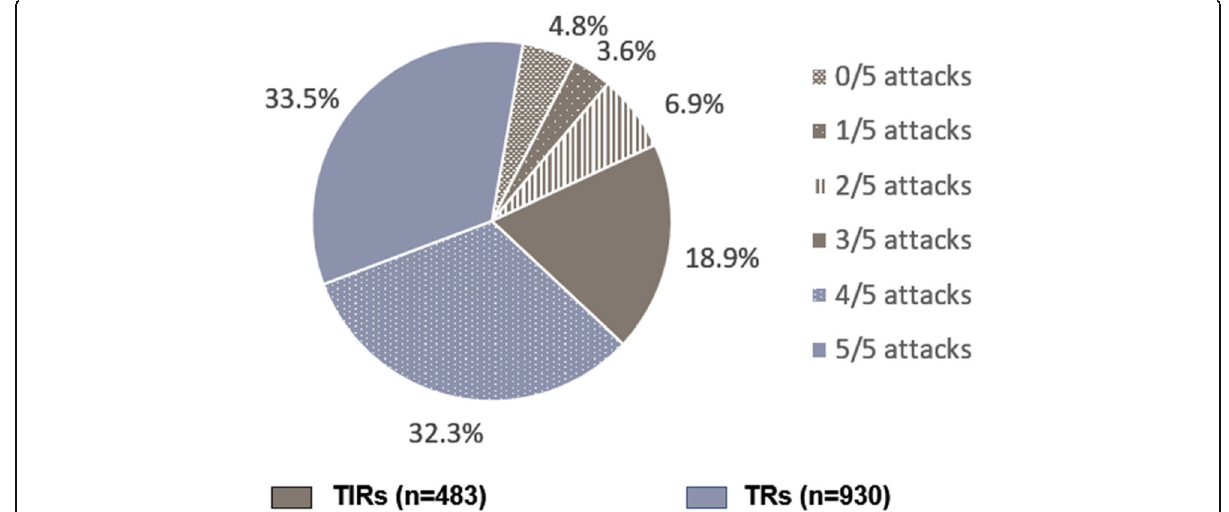
Fig. 1 Patient-reported response to triptans: attacks free from pain within 2 h of medication